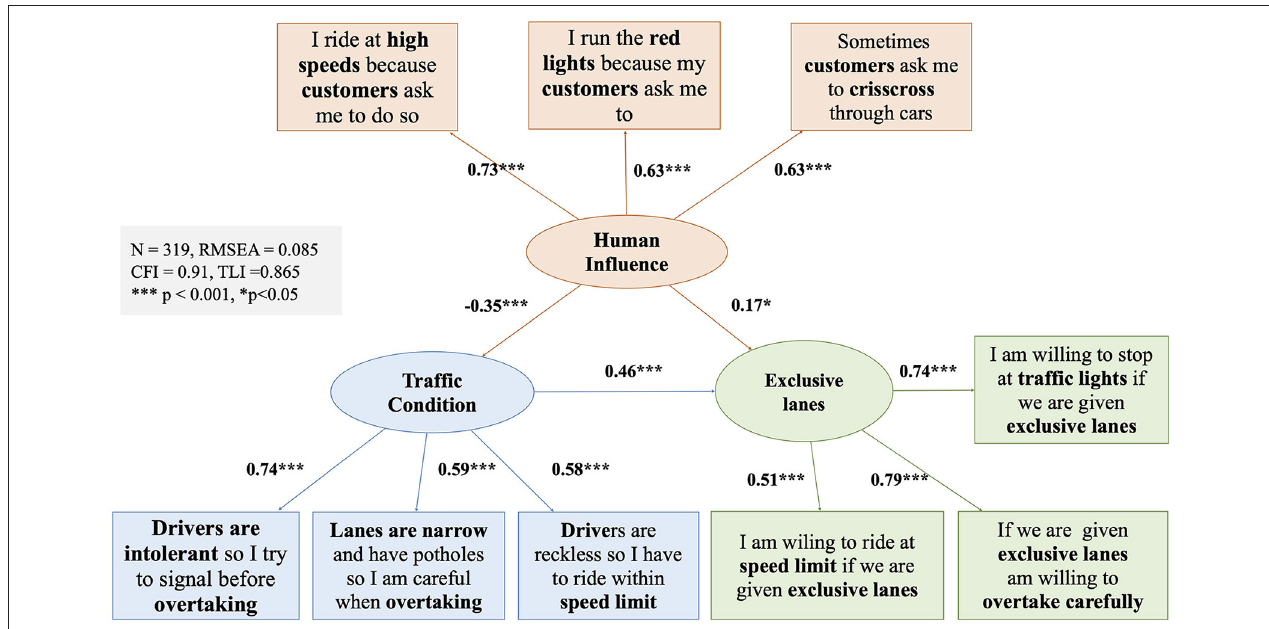
FIGURE 8 | Model 6—Effect of